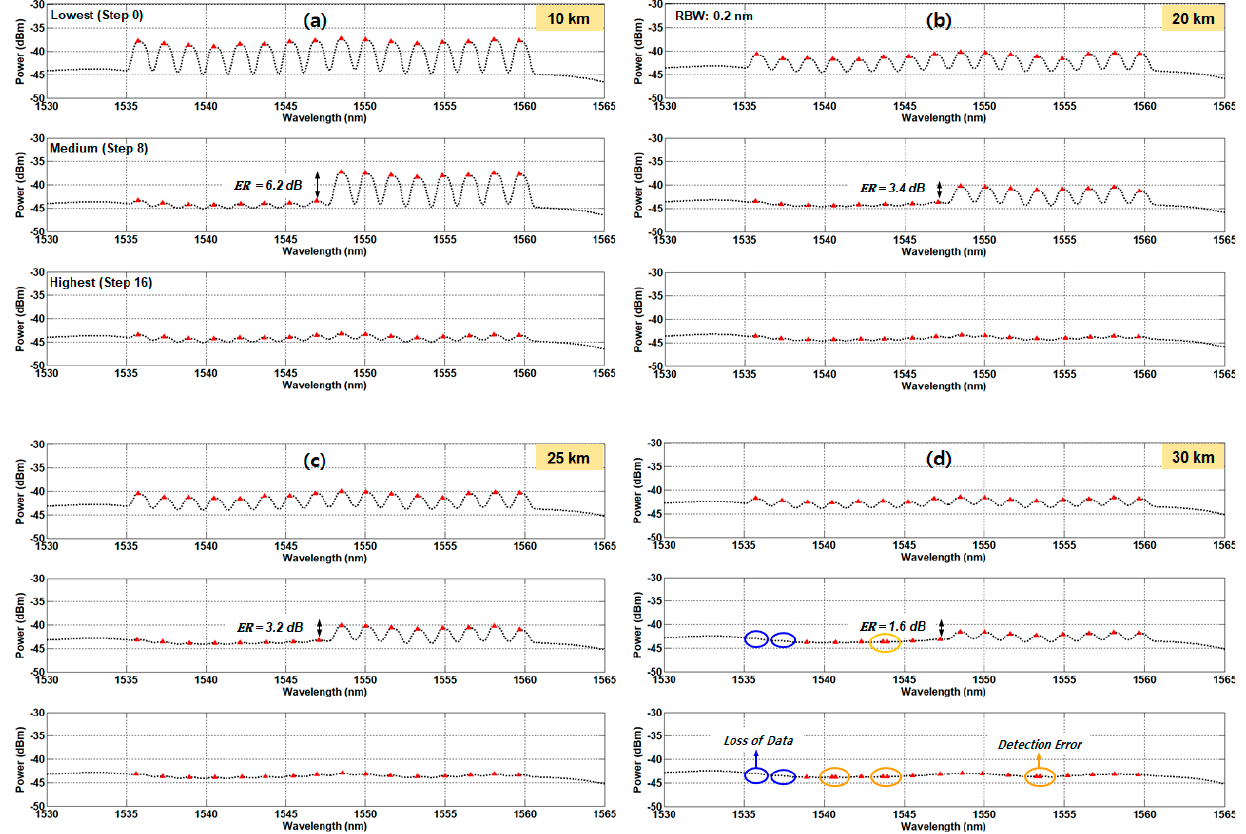
Figure 8. Measurement results according to the water level at the different distances: ( a ) 10 km, ( b ) 20 km, ( c ) 25 km, and ( d ) 30 km. ( b ) 20 km, ( c ) 25 km, and ( d ) 30